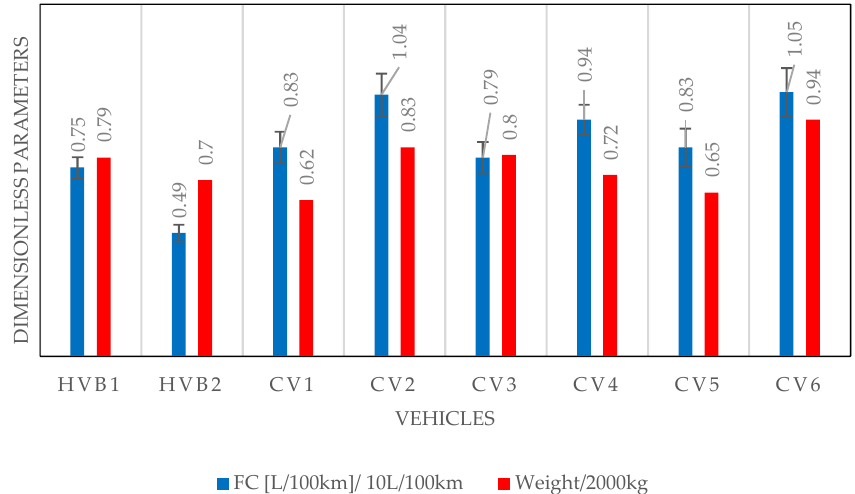
Figure 6. Dimensionless fuel economy (FC) and weight.